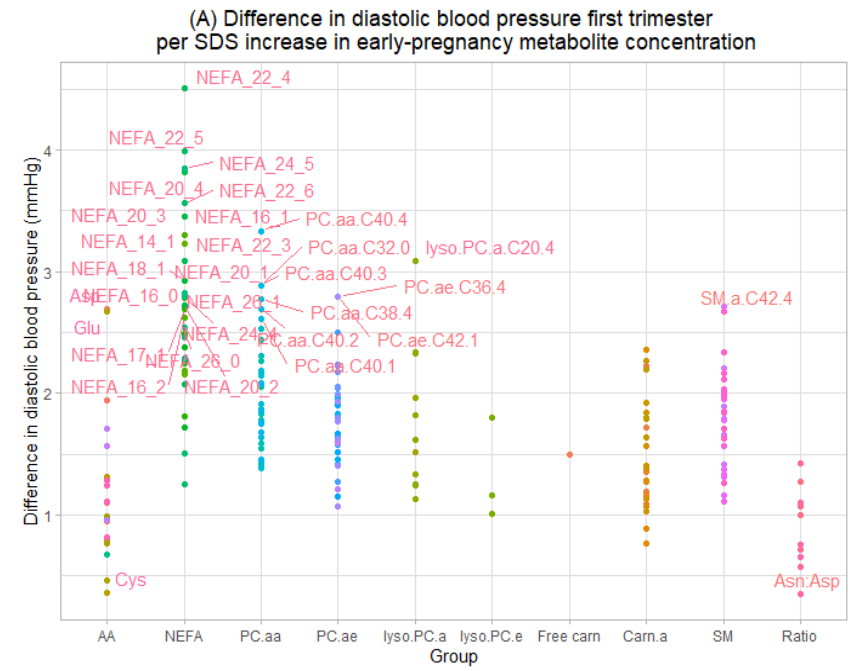
8 of 18 Figure 1. Associations of maternal serum early-pregnancy individual metabolites with systolic blood pressure in ( A ) early-, ( B ) mid- and ( C ) late pregnancy. Values represent absolute differences in blood pressure from linear regression models that reflect the difference in blood pressure (mmHg) per SDS increase in maternal early-pregnancy metabolite concentrations ( μ mol/L). Model includes gestational age at time of measurement, age, parity, pre-pregnancy body mass index, edu- cational level, smoking and folic acid supplementation. Labeled values represent significant associ- ations (FDR-adjusted p -values < 0.05). Corresponding numerical values are shown in Table S4. AA amino acids, NEFA non-esterified fatty acids, PC.aa diacyl-phosphatidylcholines, PC.ae acyl-alkyl- phosphatidylcholines, lyso.PC.a acyl-lysophosphatidylcholines, lyso.PC.e